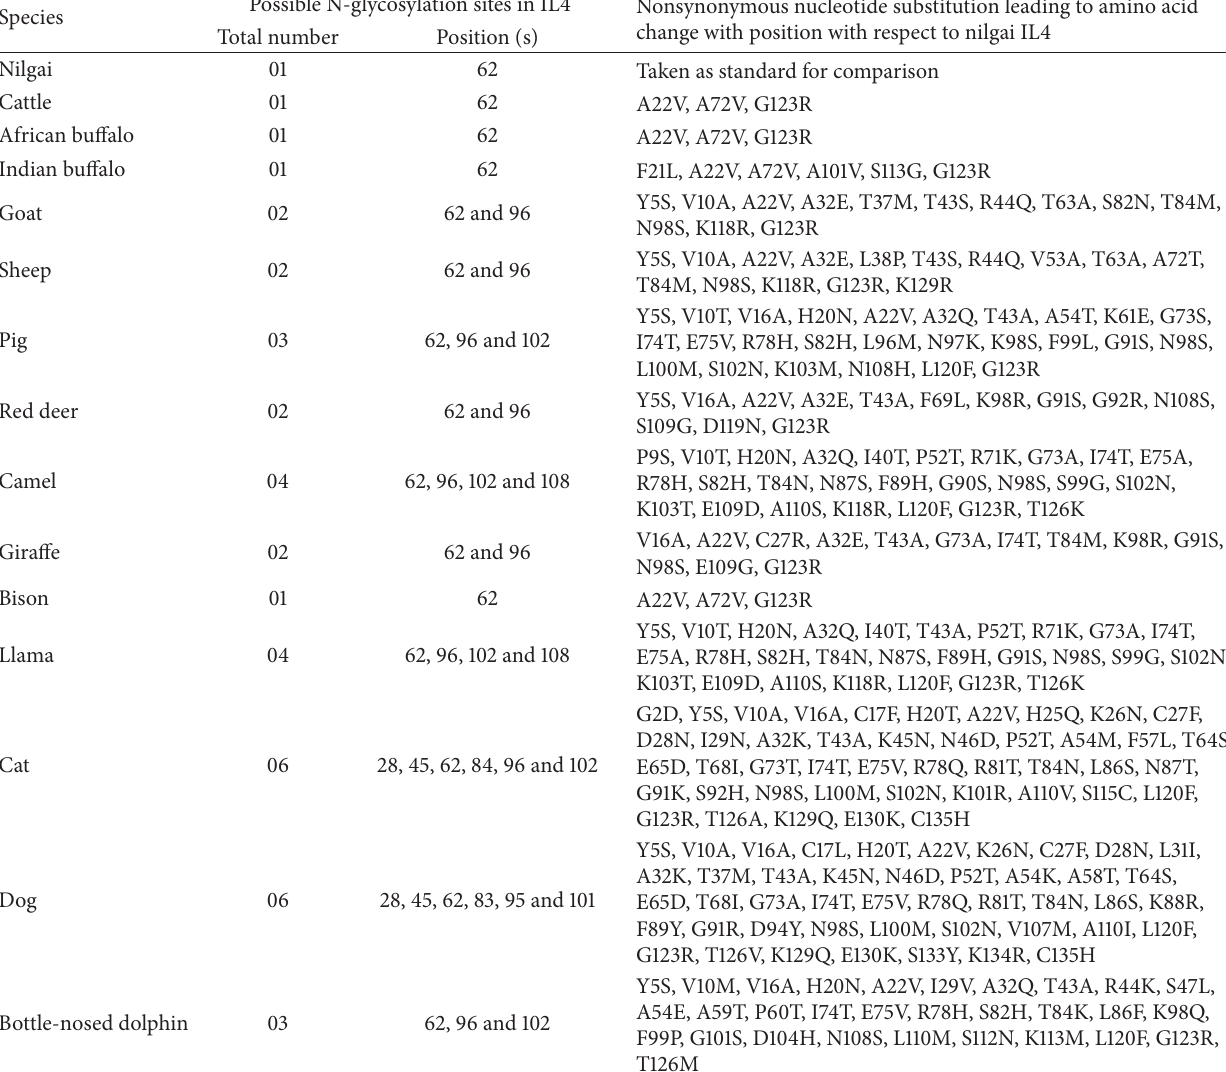
Table 1: Possible N-glycosylation sites and amino acid substitutions in various species with respect to nilgai IL4 protein. Possible N-glycosylation sites in IL4 Nonsynonymous nucleotide substitution leading to amino acid Species change with position with respect to nilgai IL4Total number Position (s) Nilgai 01 62 Taken as standard for